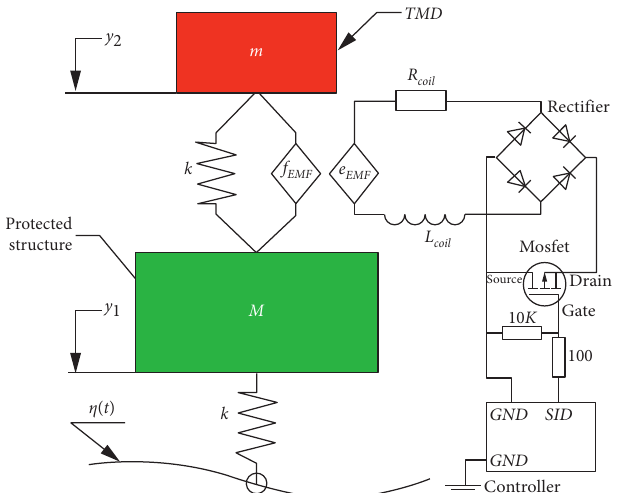
Figure 3: Schematic diagram of the controllable damping TMD system.